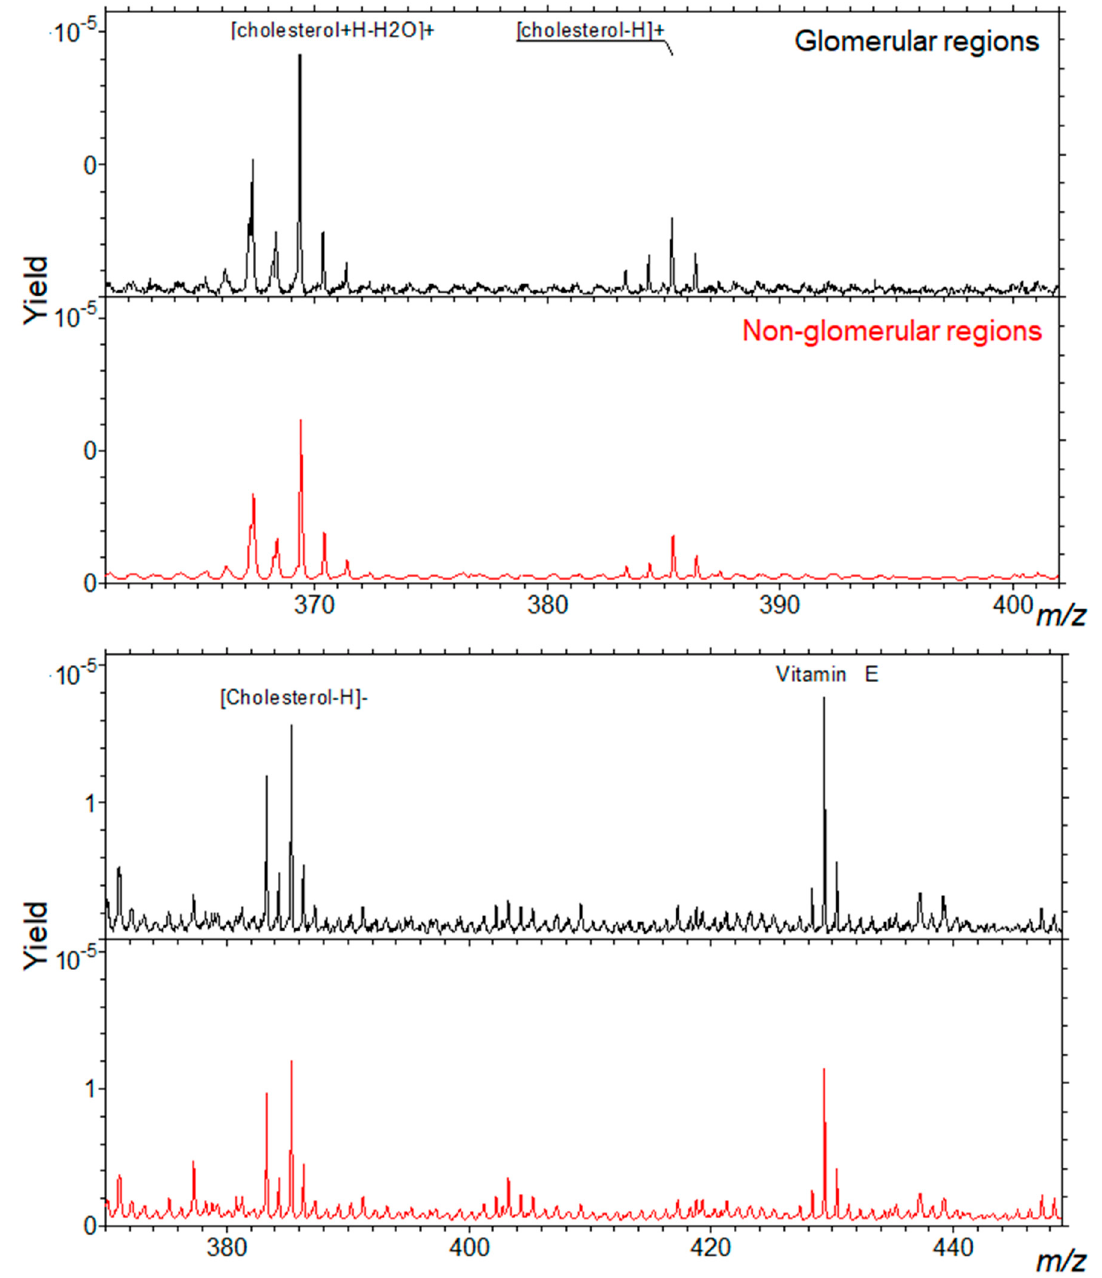
abundances. The two lower panels have been constructed by attributing one color (red or green) to each compound. Glomerular regions of interest are selected and depicted by the dashed white line. Bar length: 100 µm. The name of the compound, the maximal number of counts in a pixel (MC), and the total number of counts (TC) are written below each image.